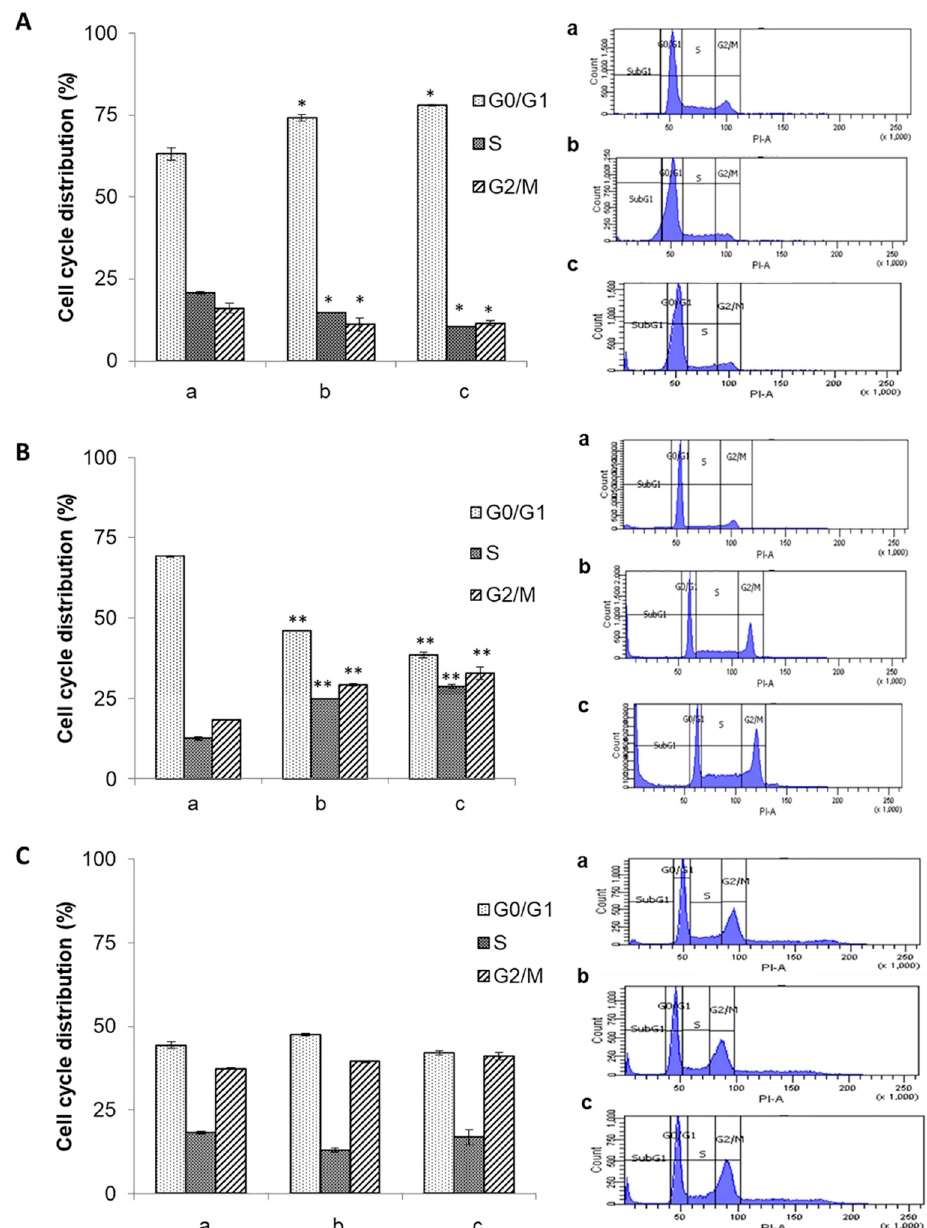
Figure 3. Modulation of the cell cycle by the ethanolic extract from defatted seeds of Euphorbia lathyris . Cell lines were treated with IC25 and IC50 doses of the extract. ( A ) T84 cell line; ( B ) HCT-15 cell line; and ( C ) CCD18 cell line (cycle (a: control; b: IC25; c: IC50). Results of the FACScan analysis are expressed as the percentage of labeled cells in each cell cycle phase. Data are presented as mean ± standard deviation of triplicate cultures. * Data with significant differences between treated and non-treated cells ( p < 0.05). ** p < 0.01, vs. the respective control group.